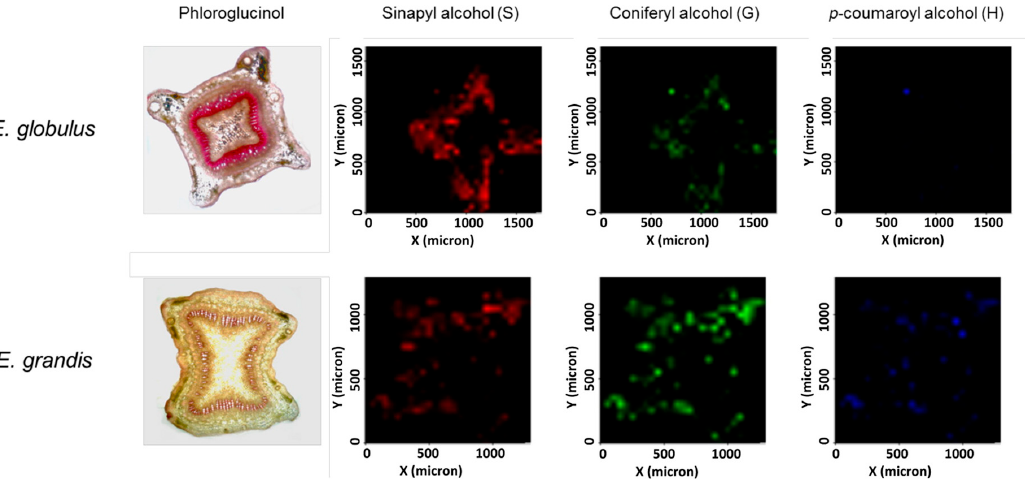
Figure 12. Phloroglucinol staining and mapping of sinapyl, coniferyl, and p-coumaroyl alcohols in freshly hand-cut sections of Eucalyptus stems. For relative quantification, the figures were converted to gray images. Reprinted from Mazzafera et al.,with permission from the ACS Publications